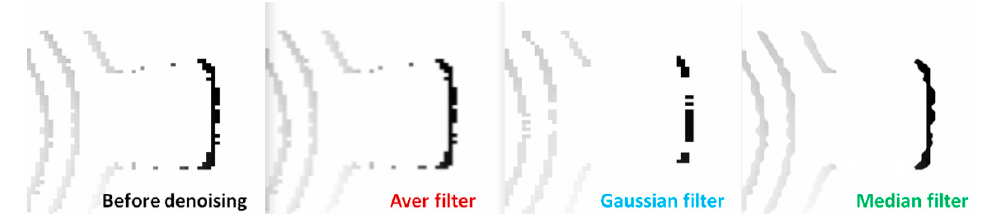
Figure 8. Three types of filtering and denoising effect comparison chart.